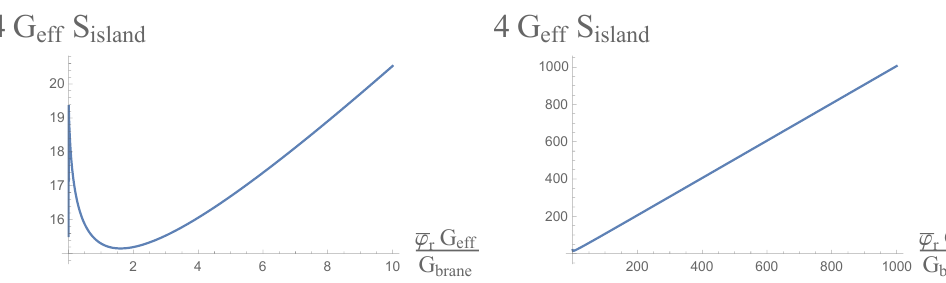
Figure 6 . Change in the final entropy of the island phase for R = 0 . 4 and the same base parameters as in figure 4. The increase quickly becomes linear. We have also assumed G plots and have ignored the ¯ ϕ